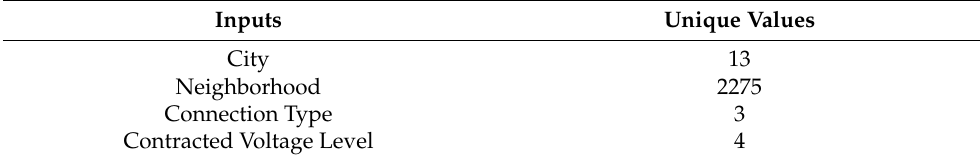
Table 6. General Inspected Consumer Units.